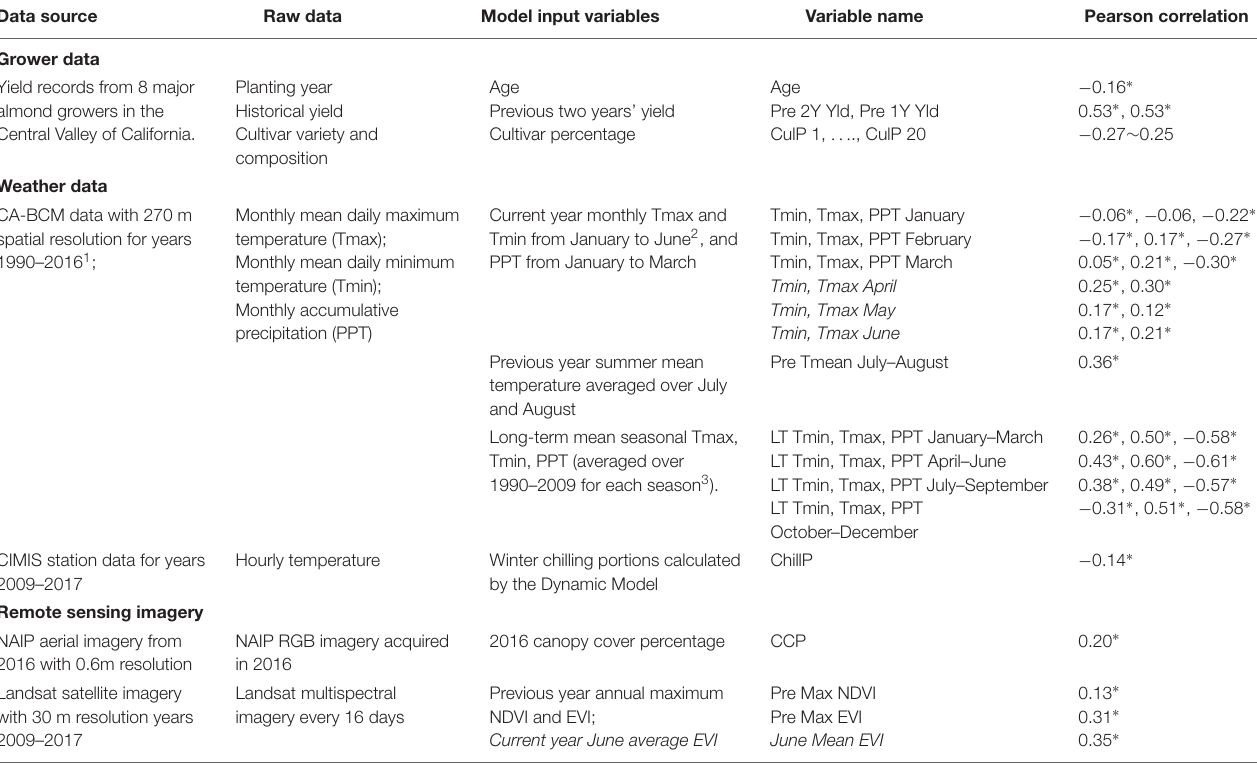
TABLE 1 | A detailed summary of the input variables for early-/mid-season SGB models. Data source